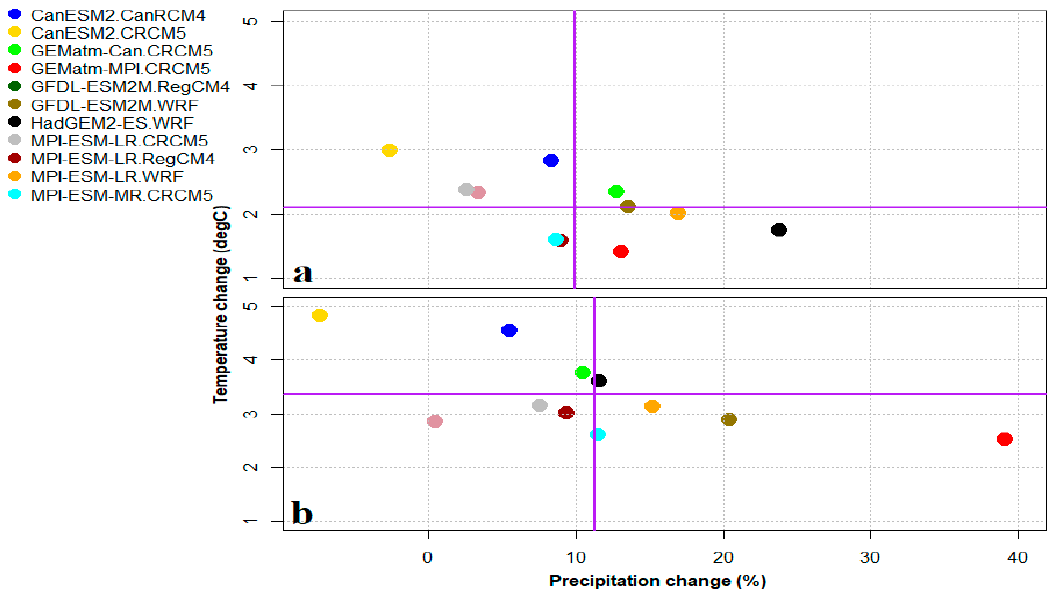
Figure 3. Scatter plots of annual changes in mean temperature and total precipitation in the region for ( a ) 2050s and ( b ) 2080s. Purple lines give average of temperature and precipitation for all RCMs.